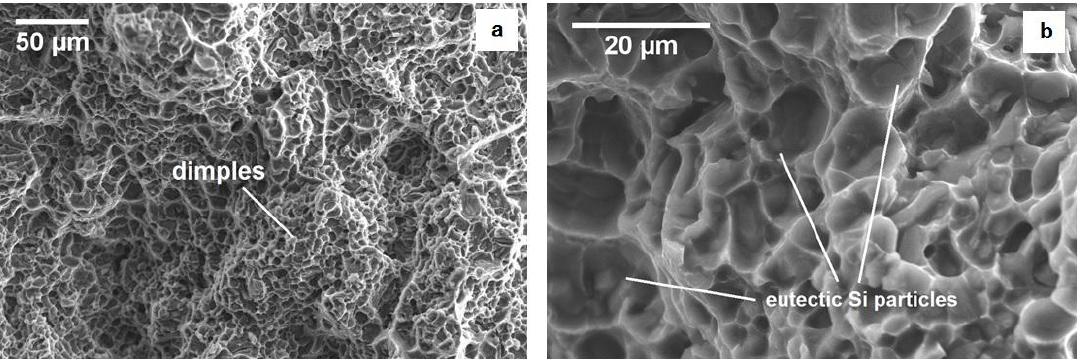
Figure 13. SEM micrographs of representative tensile fracture surfaces of A354-T6* alloy at ( a ) low and ( b ) high magnification.